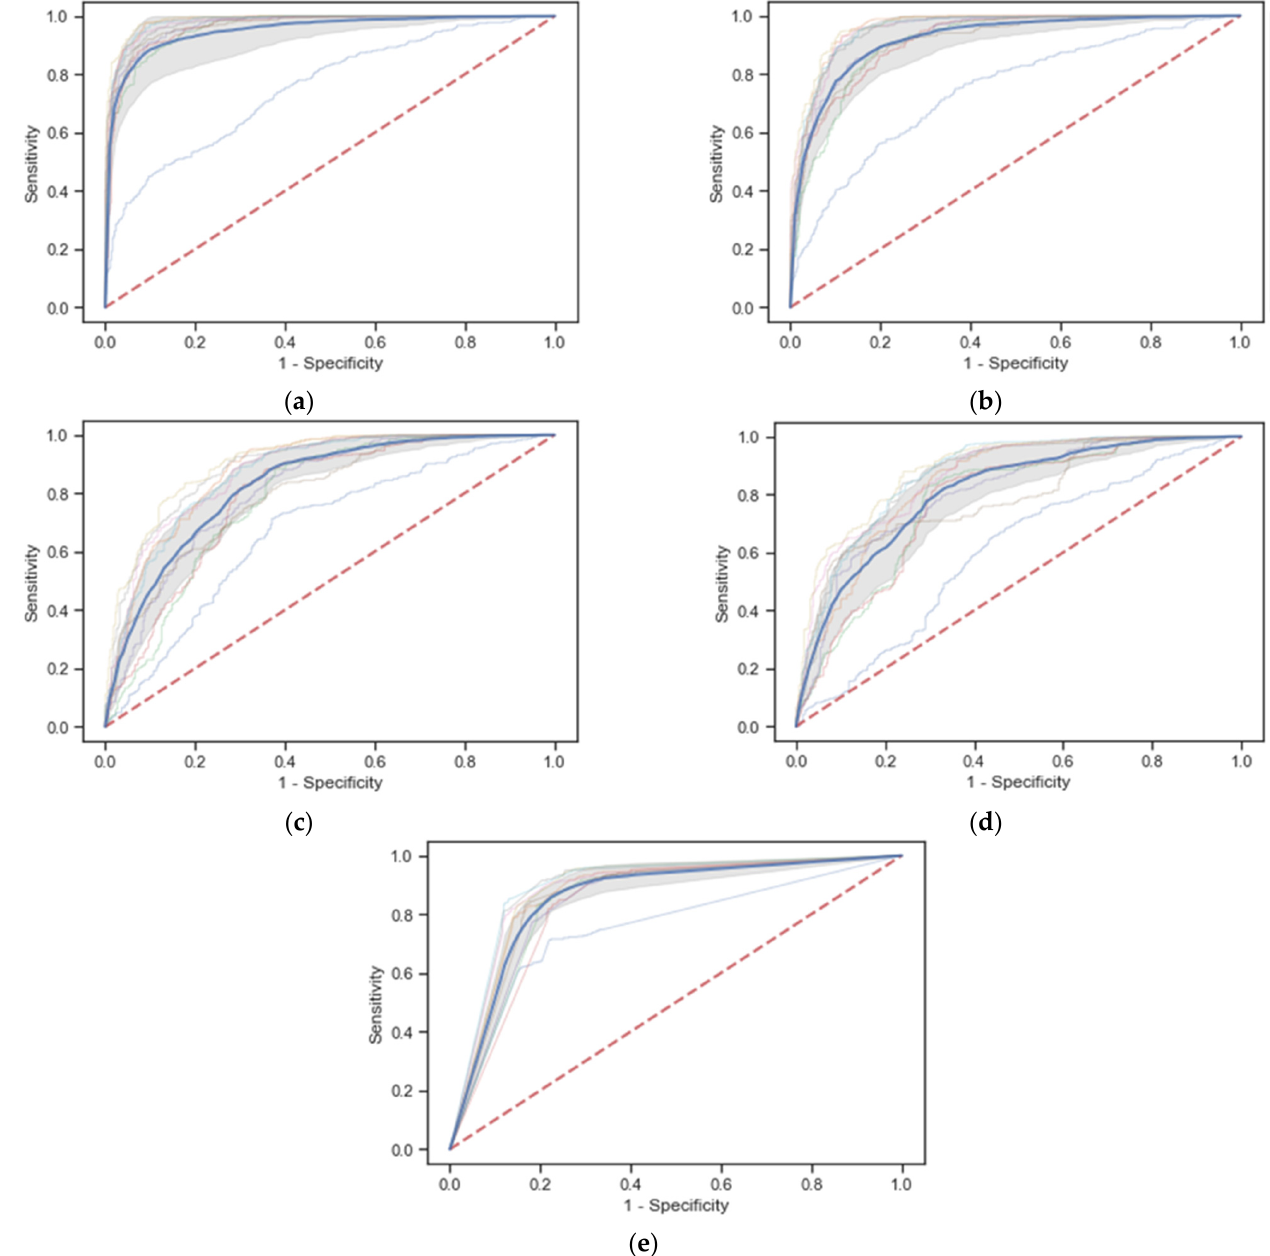
Figure 2. Receiver Operating Characteristic curves from 10-fold cross-validation of the rebalanced learning classifiers by SMOTE. ( a ) Gradient Boosting Classifier (GBC) model, mean AUC: 0.95, 95% CI: 0.90–1.00; ( b ) Random Forest (RF) model, mean AUC: 0.92, 95% CI: 0.87–0.97; ( c ) Multilayer Perceptron (MLP) model, mean AUC: 0.73, 95% CI: 0.78–0.88; ( d ) Regularized Logistic Regression (Logit) model, mean AUC: 0.73, 95% CI: 0.78–0.88; ( e ) K-Nearest Neighbor (KNN) model, mean AUC: 0.73, 95% CI: 0.78–0.88.